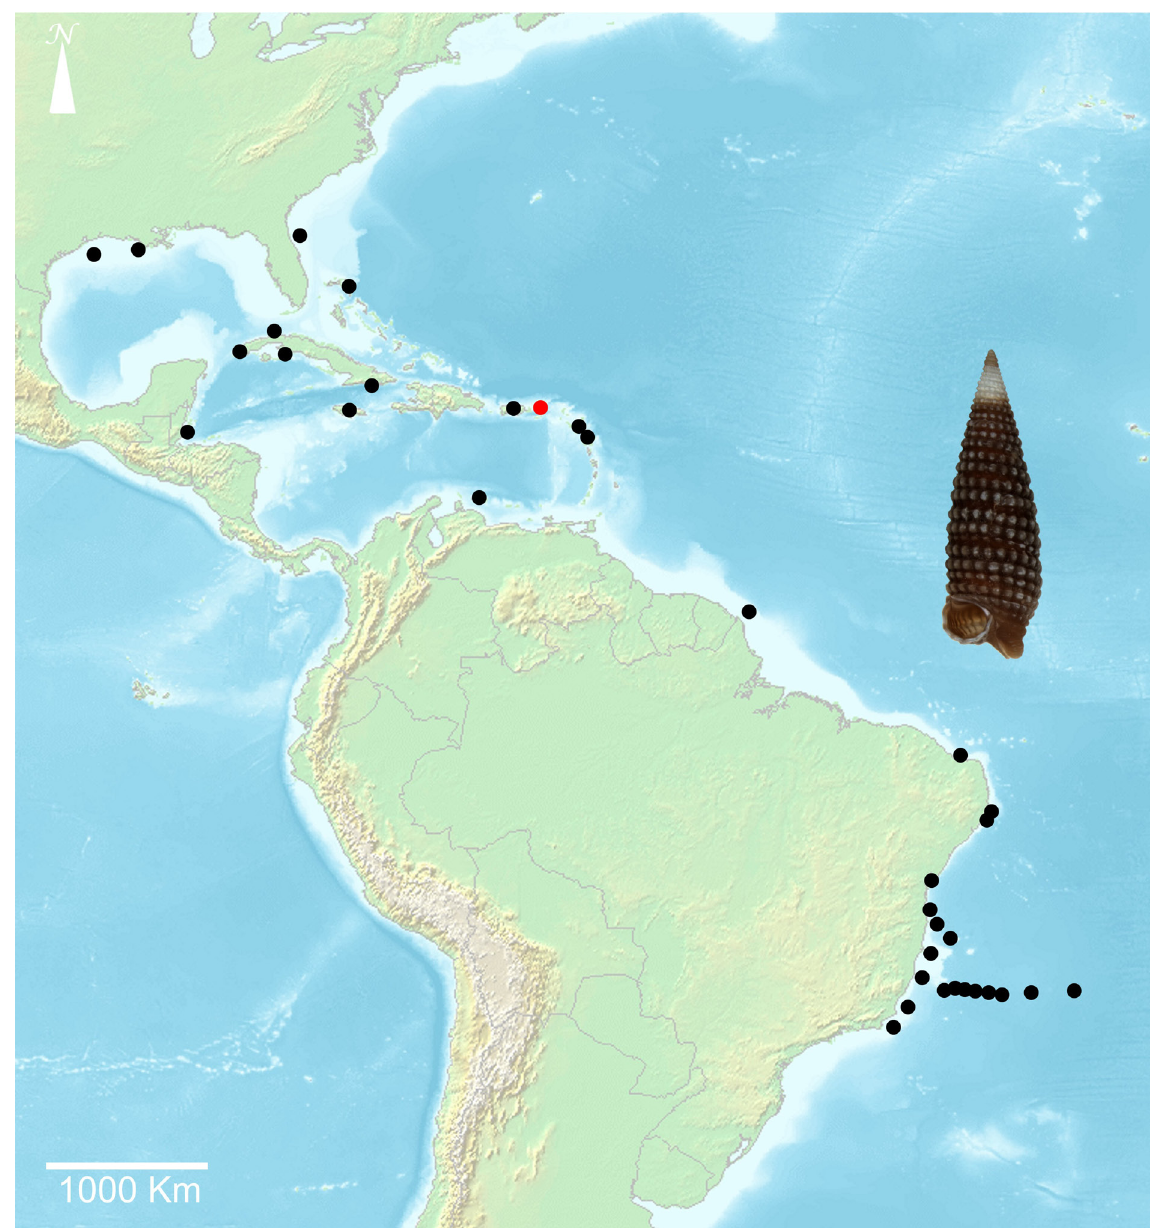
Fig. 30. Distribution map of Coriophora novem (Nowell-Usticke, 1969); red circle = type